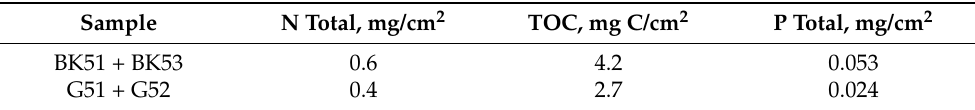
Table 2. Chemical characteristics of biofilm samples. BK51, BK53—Bol’shiye Koty biofilms; G51, G52—Bol’shoye Goloustnoye